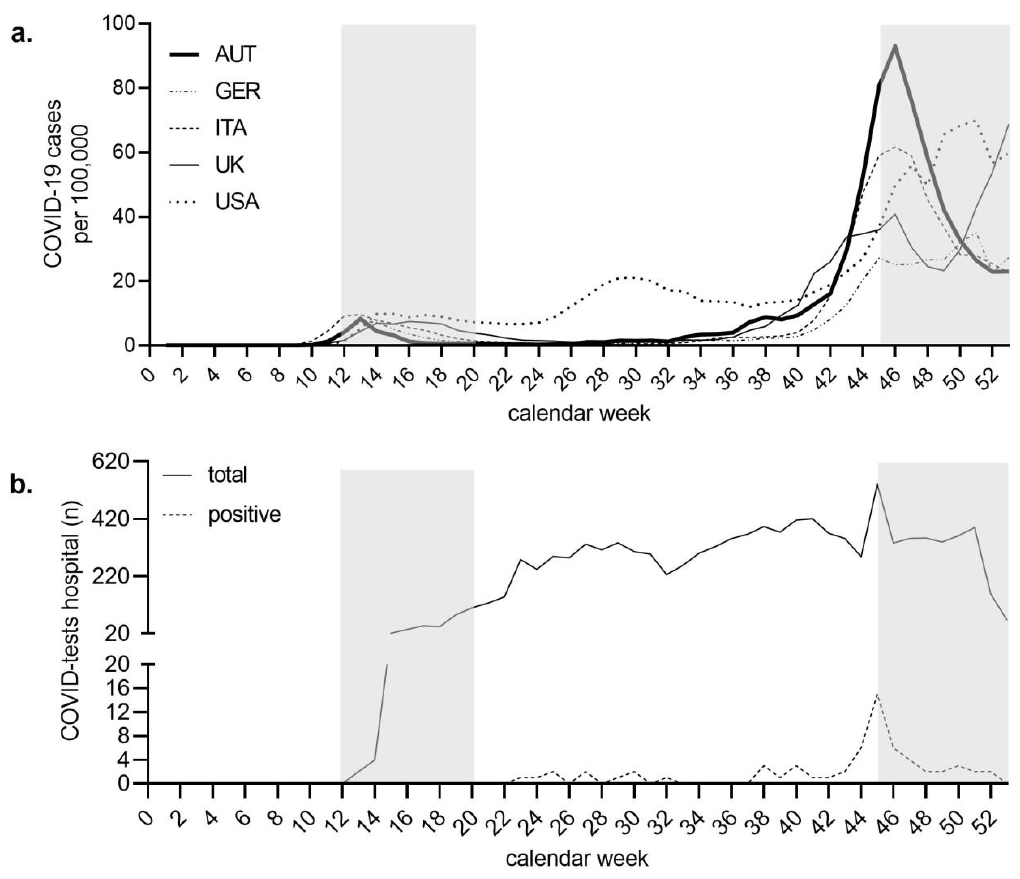
Figure 1. COVID-19 cases and performed tests. ( a ): Daily new cases per 100,000 per calendar week for Austria (AUT), Germany (GER), Italy (ITA), the UK, and the USA. The grey shaded areas visualize the first and the second wave in Austria. ( b ): Absolute number of performed and positive tests in our center per calendar week. The grey shaded areas visualize the first and the second wave in Austria.